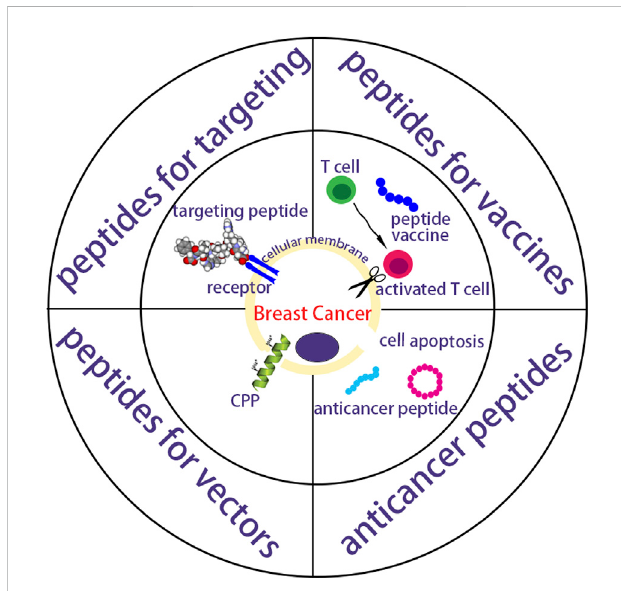
FIGURE 1 A schematic summarization of peptides as targeting vectors, vaccines and anticancer drugs for breast